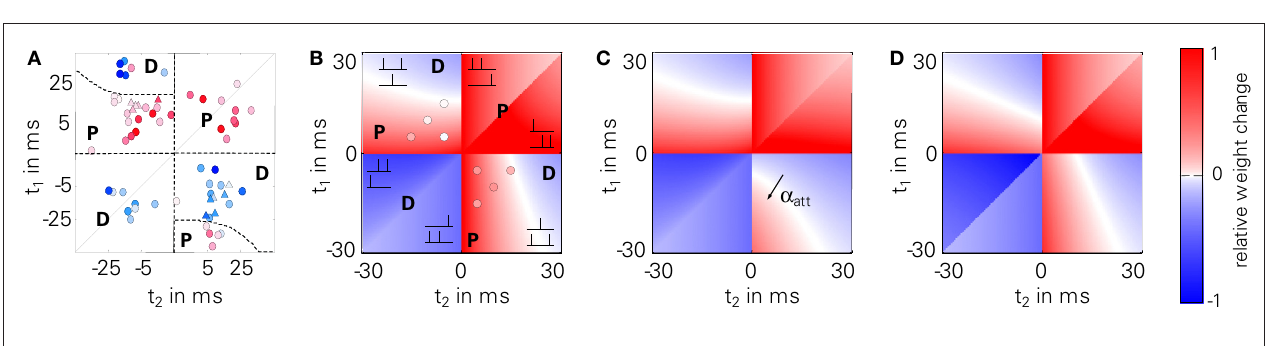
data by Wang et al. (2005) (error to Wang data for LCP with SRM and Wang parameter set: E = 10.2); (C) LCP with SRM with postsynaptic attenuation ( α = 0.8); (D) standard STDP rule with same parameters, for comparison (error att to Wang data with Wang parameter set: E =